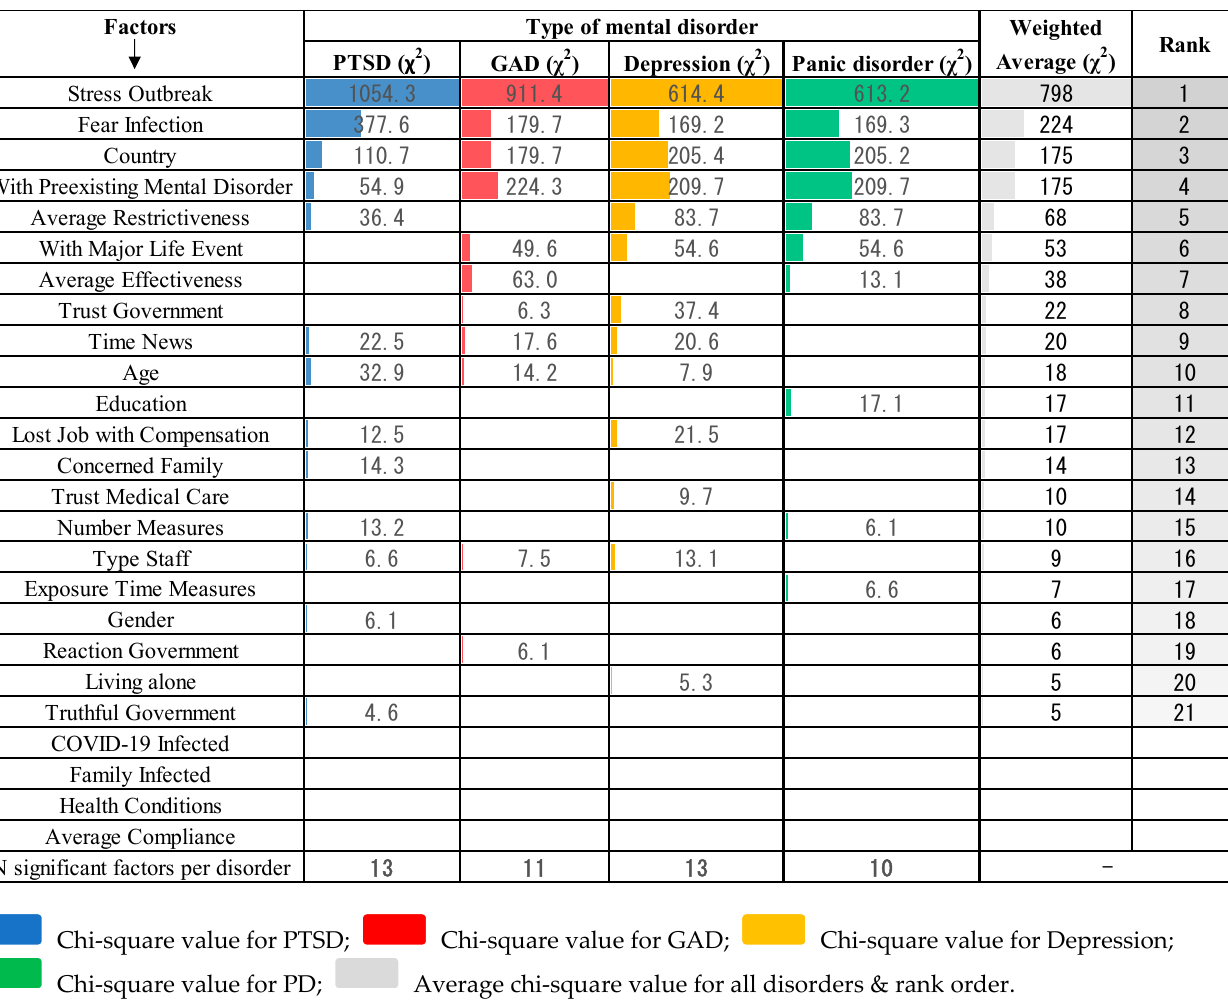
Figure 2. Rank order of associated factors with PTSD, anxiety, depression, and panic disorder according to their Chi-square value ( χ ²).